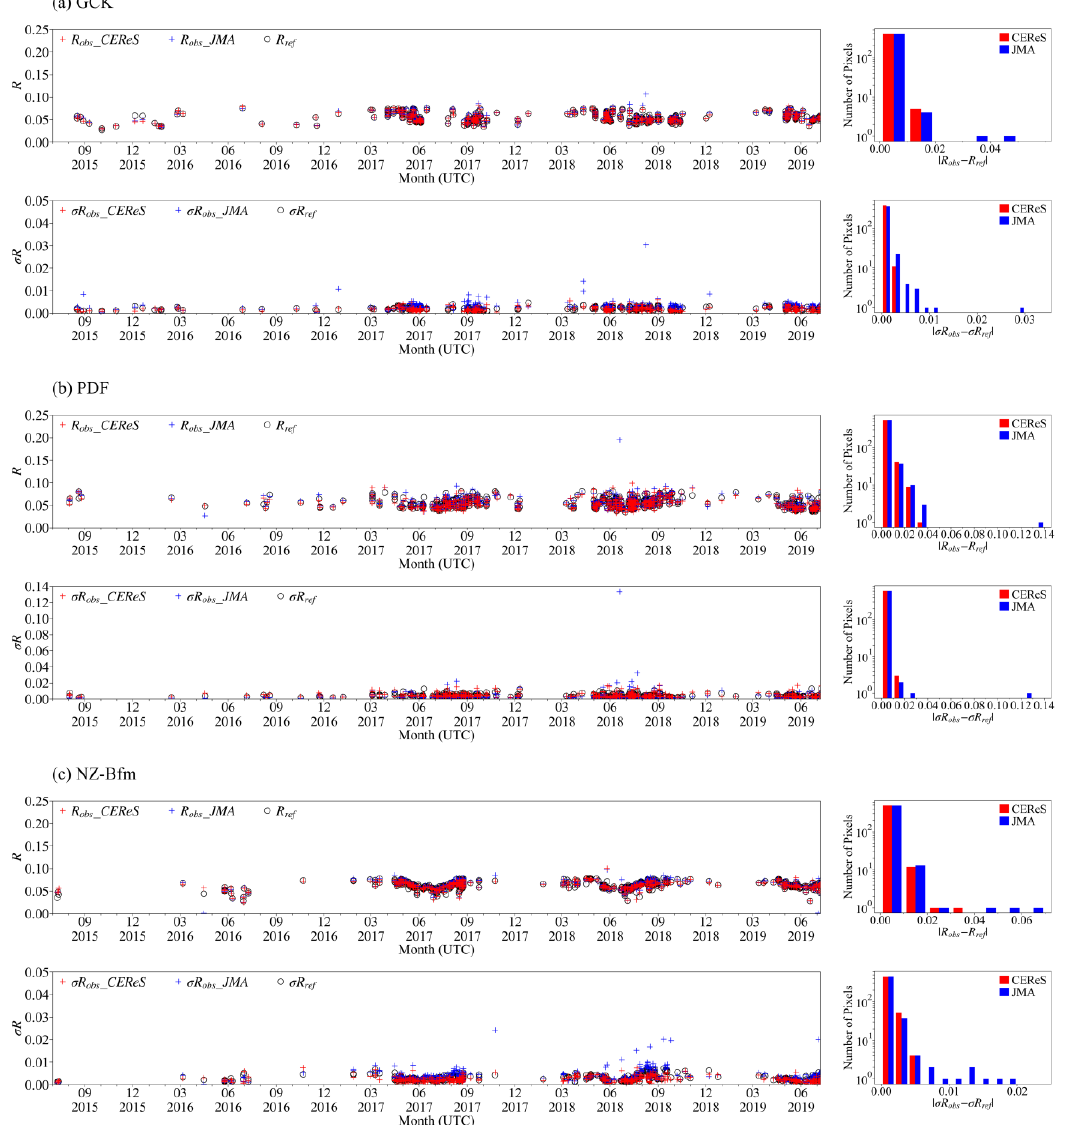
Figure 7. Results of the stability evaluation in ( a ) GCK, ( b ) PDF, and ( c ) NZ-Bfm. Upper left-hand: time series of R obs_CEReS , R obs_JMA , and R ref . Upper right-hand: histogram of R obs_CEReS – R ref (red) and R obs_JMA – R ref (blue). Lower left-hand: Similar to upper left-hand but for σ R obs_CEReS , σ R obs_JMA , and σ R ref . Lower right-hand: Similar to upper right-hand but for σ R obs_CEReS – σ R ref (red) and σ R obs_JMA – σ R ref